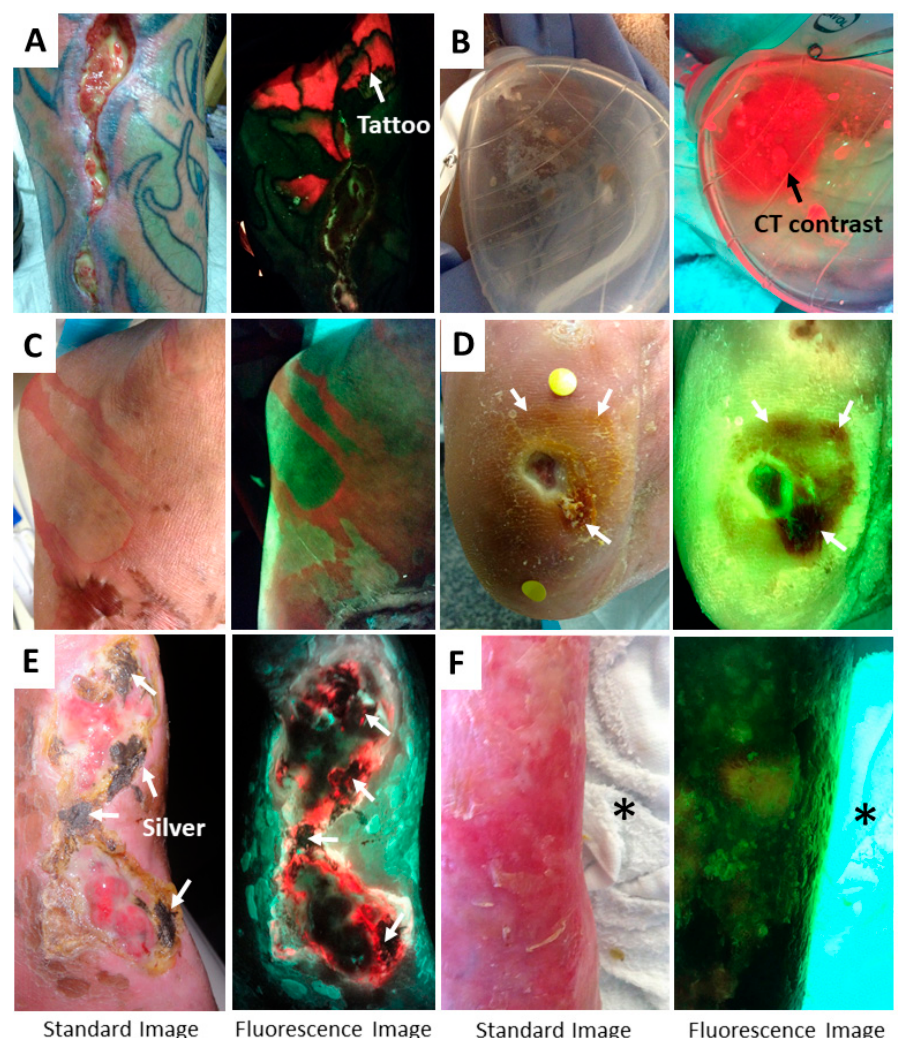
Figure 8. Confounding signals. ( A ) Bright red fluorescence from a tattoo. ( B ) Fluorescent red CT contrast agent observed within a Jackson Pratt wound drainage system for a patient undergoing a sinogram. ( C ) Pink chlorohexidine on a patient’s foot and ankle. This solution is tinted with pink to enable clinicians to see where the tissue has been cleaned; the tinting appears red/pink on fluorescence images. ( D ) Images of a wound after application of iodine during cleaning. Arrows denote the region of iodine, which appears reddish brown on the standard image and dark on the fluorescence image. ( E ) Venous leg ulcer with residual silver product (white arrows) on the wound. Regions with silver product on standard images result in regions of black on fluorescence images, as the violet illumination light cannot penetrate through the silver. If possible, silver products should be removed from the wound prior to imaging. ( F ) Bright fluorescence from a white bed sheet (asterisk) in the field of view. Clinicians should be aware that white items in the field of view may fluoresce.